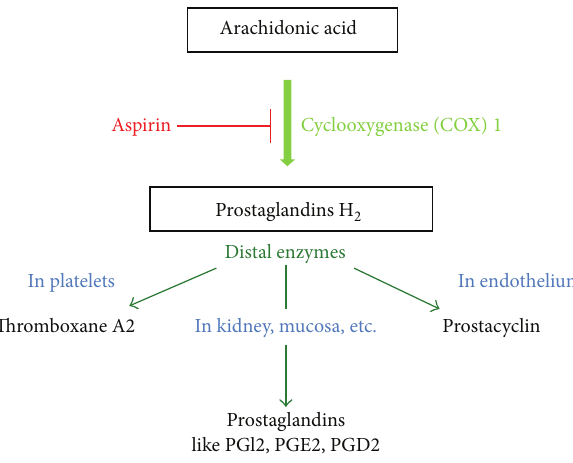
Figure 2: Interaction of aspirin with COX